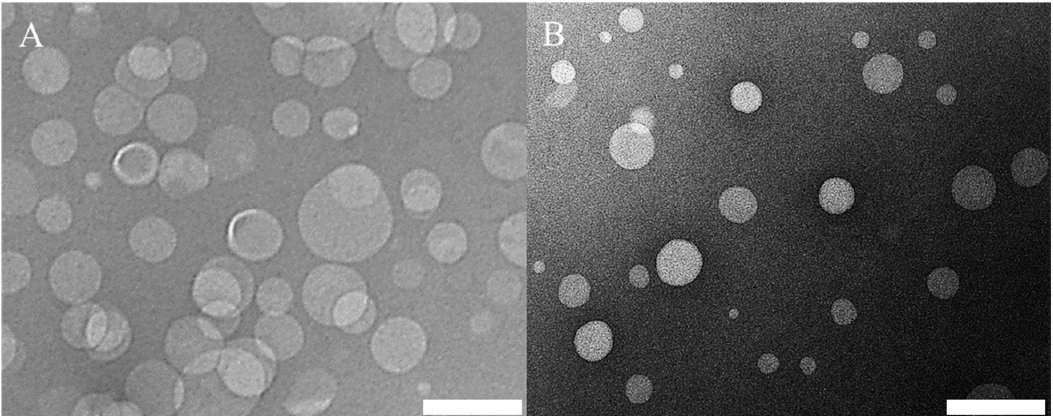
Figure 11. TEM images of liposome formulations of ( A ) PC/Chol and ( B ) PC/ODA/Chol. Please refer to Table 1 (batch codes #20 PC and #25 PC) for the corresponding experimental conditions and lipid compositions. Scale bars: 200 nm.